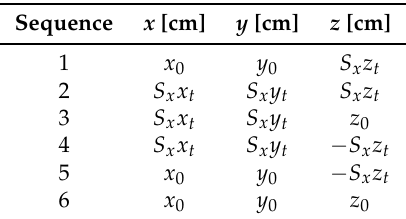
Table 4. Target positions in each